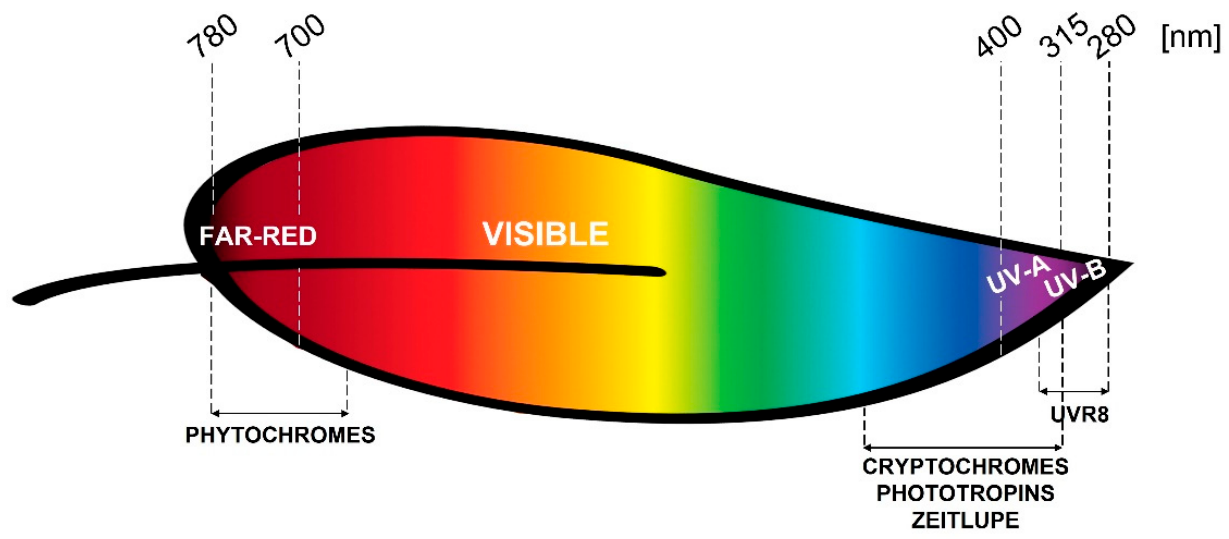
Figure 1. Wavelength ranges within the solar spectrum perceived by the different photoreceptors in plants.